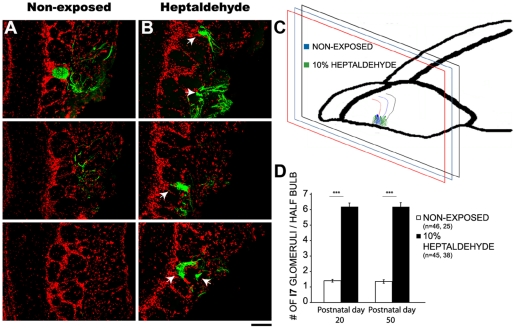
Supernumerary glomeruli persisted after interrupting chronic odorant exposure.Figures A and B show representative I7tauGFP glomeruli (green) in coronal brain slices stained with DAPI (red) from non-exposed mice and from those exposed to 10% heptaldehyde and later raised without the odorant until postnatal day 50. Arrowheads indicate supernumerary glomeruli. Scale bar 100 µm. Figure in C shows a schematic side view representation of the olfactory bulb, indicating the anterior ventrolateral position of I7 glomeruli in the coronal plane in non-exposed mice and in those exposed to 10% heptaldehyde, according to the location across brain slices. Bar graph in D shows the average number of I7 glomeruli per half bulb 30 days after the end of exposure. Kruskal-Wallis sum rank test: p<0.01 followed by Dunn multiple comparison test: ***, P<0.001.